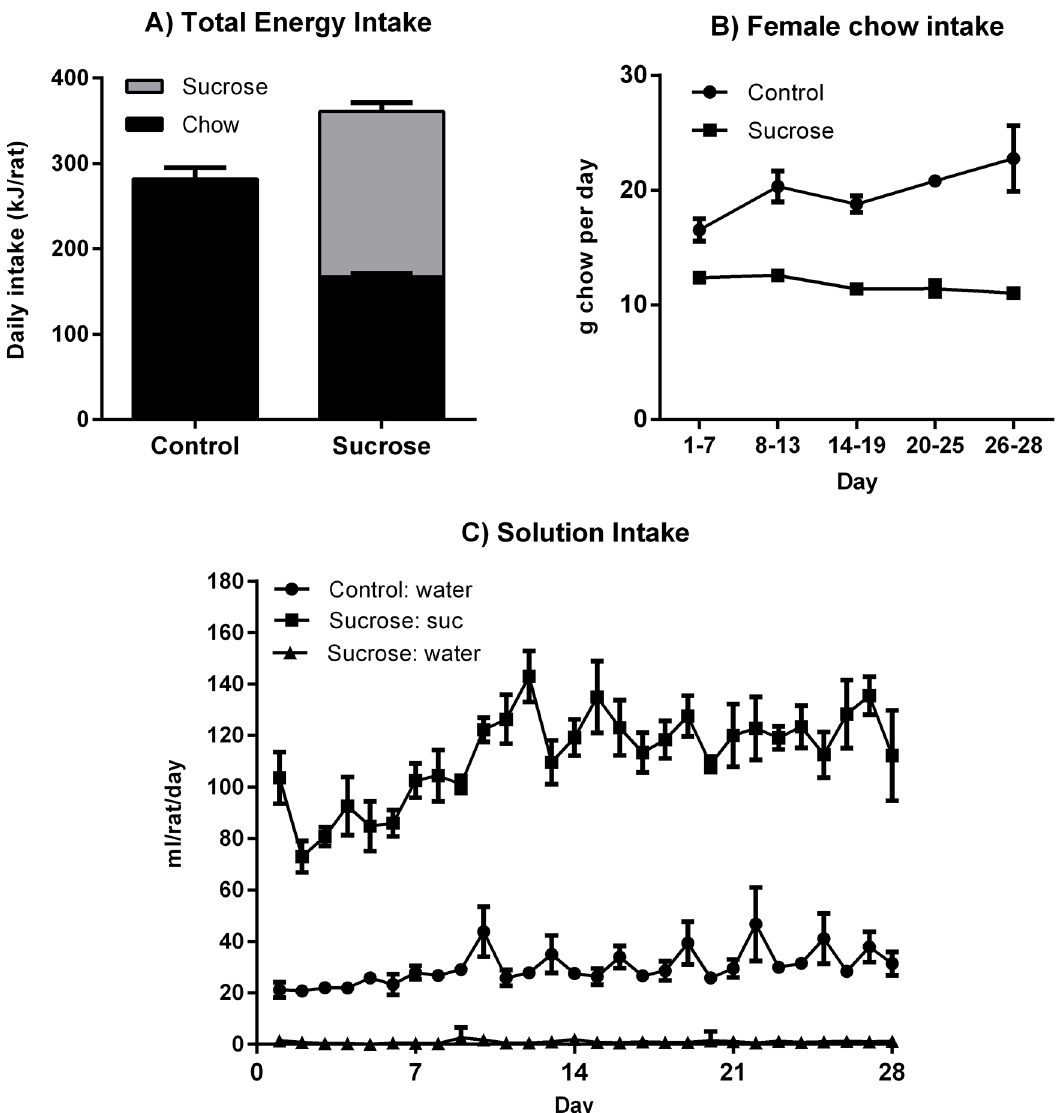
Fig 2. Consumption data during maternal sucrose feeding. Female rats with free access to 10% sucrose solution consumed more calories than water- only Controls (Panel A) and compensated partially for liquid calories by eating less chow (Panel B). The Sucrose group drank sucrose almost exclusively and their liquid intakes were substantially higher than water intakes in Controls (Panel C). ** p <